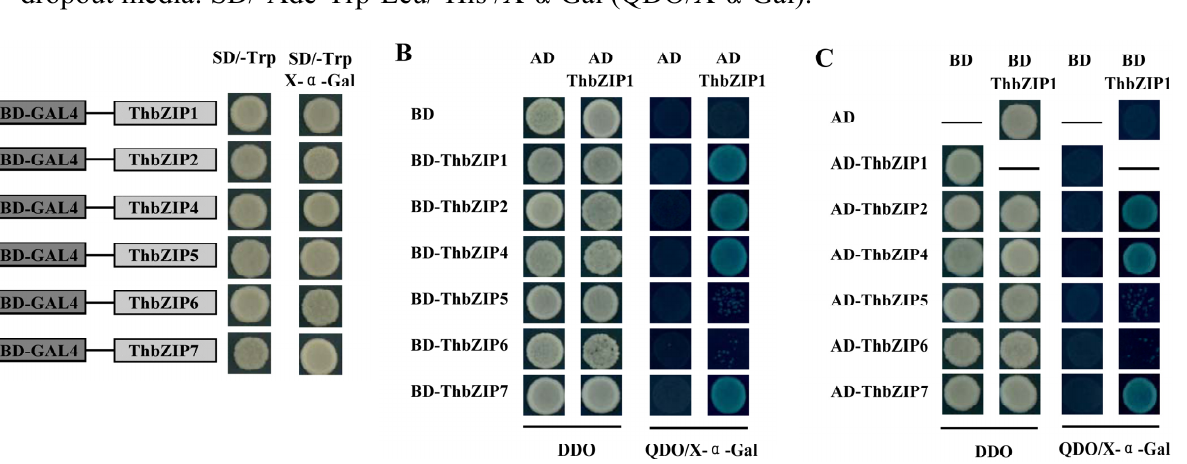
Figure 1. Autoactivation, homodimeric, and heterodimeric analysis of ThbZIPs using a yeast two-hybrid assay (Y2H). ( A ) Transactivation assay of ThbZIPs. Fusion proteins of the GAL4 DNA-binding domain and ThbZIPs were checked for their transactivation activity using the Y2H system. None of the ThbZIPs had autoactivation or toxicity, and were therefore competent for a Y2H analysis; ( B ) ThbZIP1 was cloned into a pGBKT7 vector (Clontech) and interacted respectively with itself and the other five bZIP proteins that were cloned into pGADT7 (prey); and ( C ) ThbZIP1 was cloned into pGADT7 vector (prey) and interacted with itself as well as the other five bZIP proteins cloned into the pGBKT7 vector (baits). The yeast cells were grown on SD/-Trp-Leu (DDO) and selective dropout media: SD/-Ade-Trp-Leu/-His /X- α -Gal (QDO/X- α